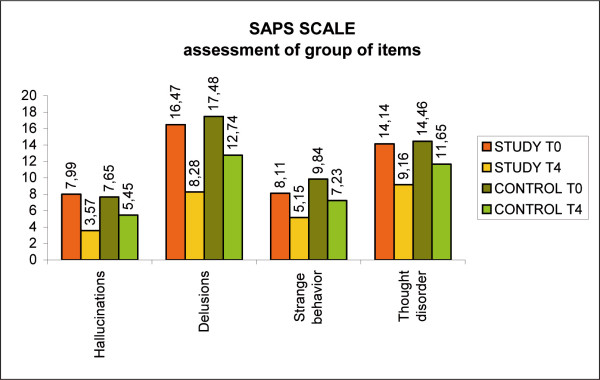
SAPS scale, group of items.